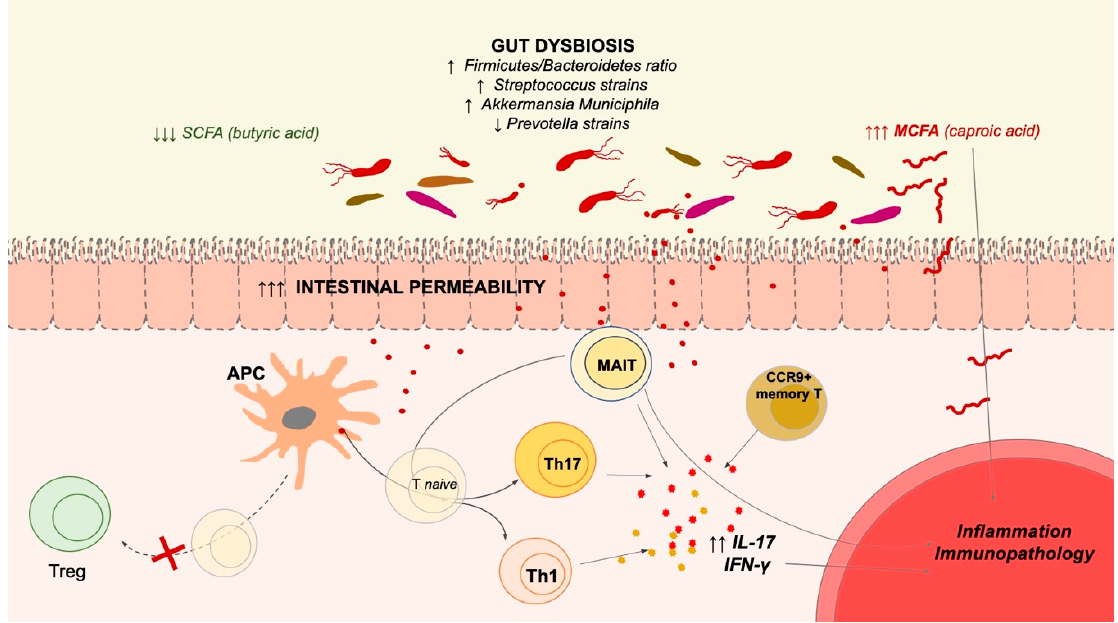
Figure 1. Gut dysbiosis in multiple sclerosis. Abbreviations: SCFA=short chain fatty acid; MCFA=medium chain fatty acid; Treg= T regulatory cell; APC=antigen presenting cell; Th=T helper cell; IL-17=interleukin 17; IFN- γ = interferon gamma. Upward or downward arrows denote respectively increase or decrease of figure components.